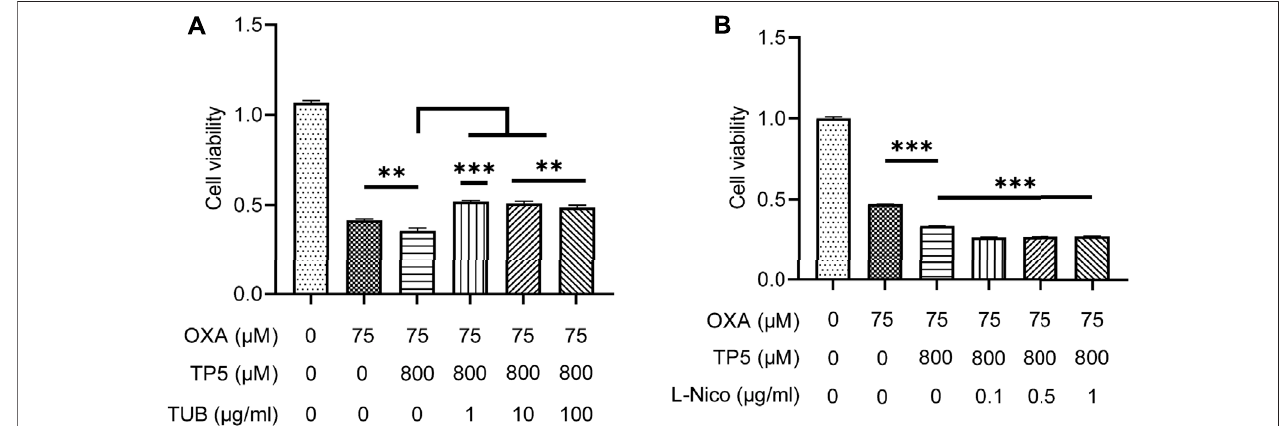
FIGURE 9 | TP5 promotes the inhibitory effect of OXA on colon cancer cell proliferation via AchRs. (A, B) HCT116 cells were tested for cell viability after treatment with TP5 and OXA, or in combination with AchR inhibitors TUB (1, 10 and 100 μ g/ml) (A) , or with AchR agonists L-Nico (0.1, 0.5 and 1 μ g/ml) (B) for 48 h. All data are represented as mean ± SD. ** p < 0.01, *** p < 0.001, unpaired two-tailed Student ’ s t -test; ns, not signi fi